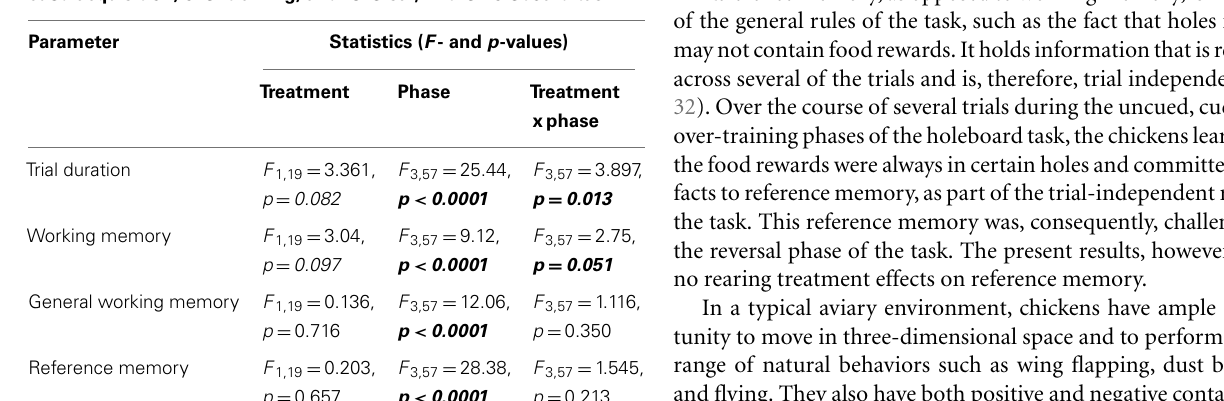
Table 2 | Results of repeated measuresANOVA testing effects of treatment (cage or aviary rearing) and phase (uncued acquisition, cued acquisition, over-training, and reversal) in the holeboard task